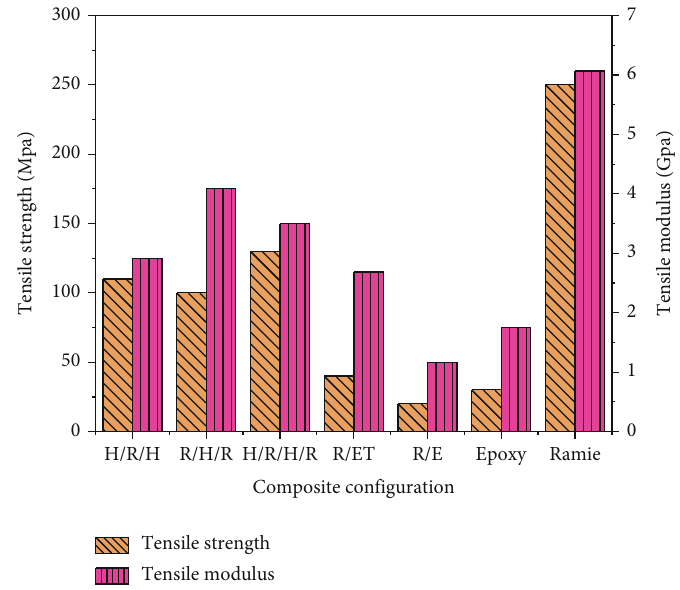
Figure 4: Tensile strength and modulus of R/H hybrid composites, R/E, pure epoxy, and H/E.